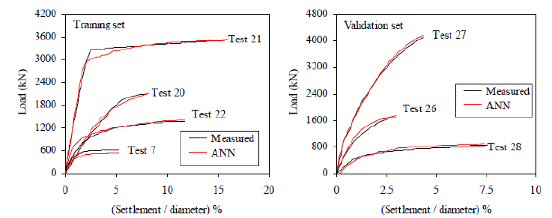
Figure 7. Some simulation results of the developed ANN Model for driven steel piles in training and validation sets.